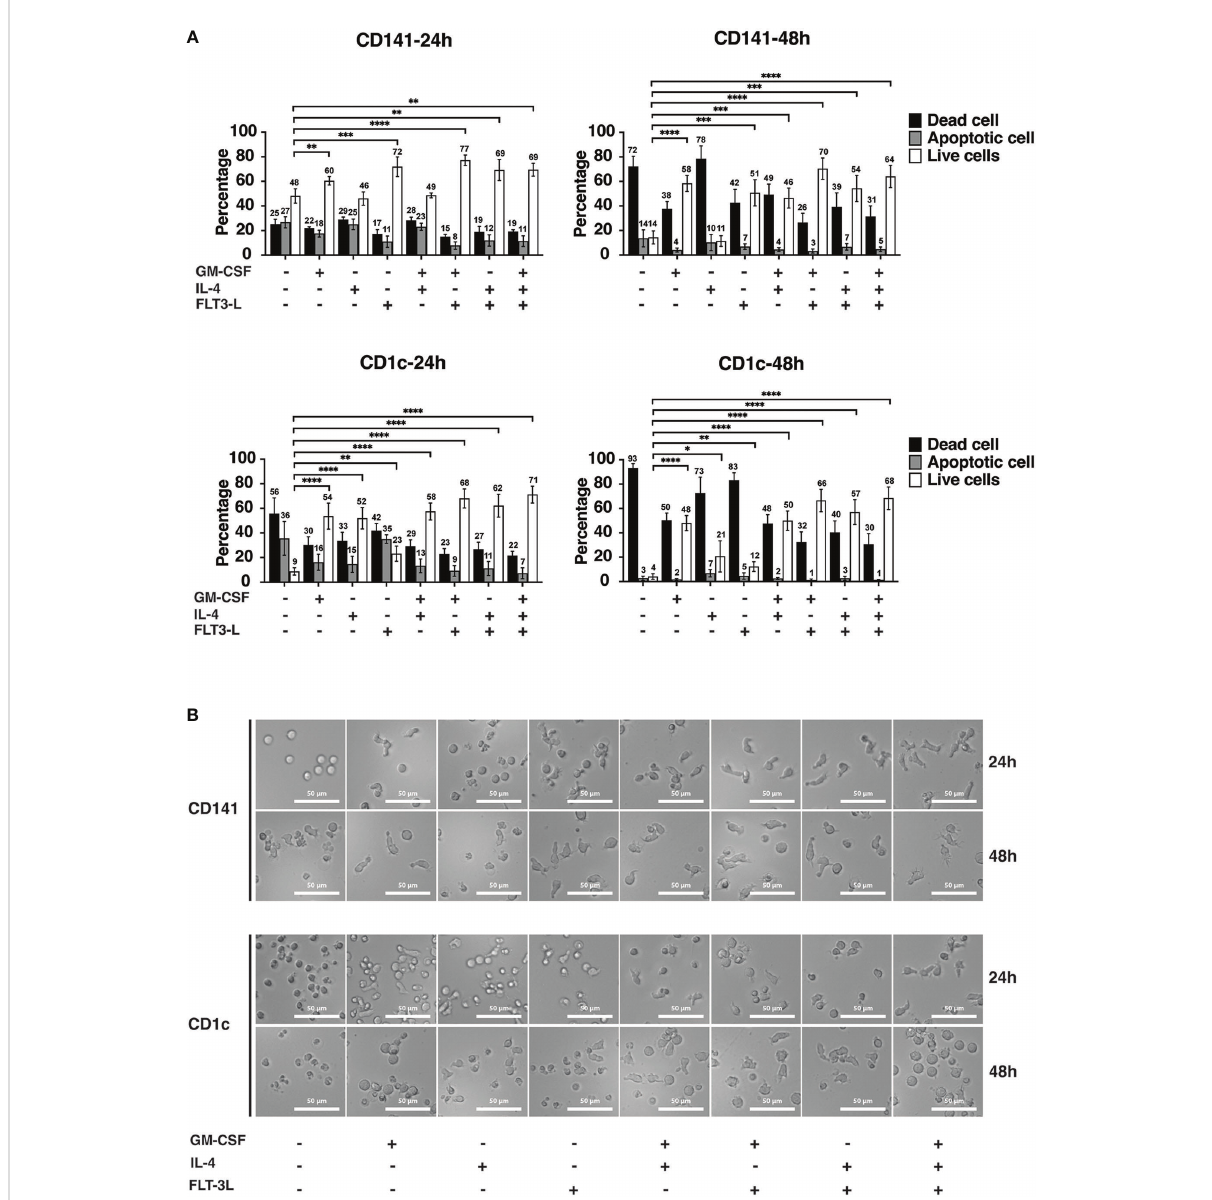
FIGURE 2 Cytokines improve the viability of dendritic cells in vitro . (A) CD141+ and CD1c+ cells were treated with different cytokines and cytokine combinations in Cellgenix DC medium as indicated. The concentrations were the following: GM-CSF (100 ng/ml), IL-4 (20 ng/ml), and Flt3-L (100 ng/ml). Cells were seeded in media containing cytokines right after sorting and incubated at 37°C for 24hrs and 48hrs. The graph indicates the summary of fi ve biological replicates, and mean values S.D. are shown. p values were calculated using Student ’ s t test with ****, p ≤ 0.0001; ***, p ≤ 0.001; **, p ≤ 0.01; *, p ≤ 0.05. (B) For analysis of morphological changes upon cytokine treatment, cells were imaged after 24hrs and 48hrs using inverted phase-contrast microscopy. The experiments were performed at least three times, and representative images of one experiment are presented. The scale bar is 50 m